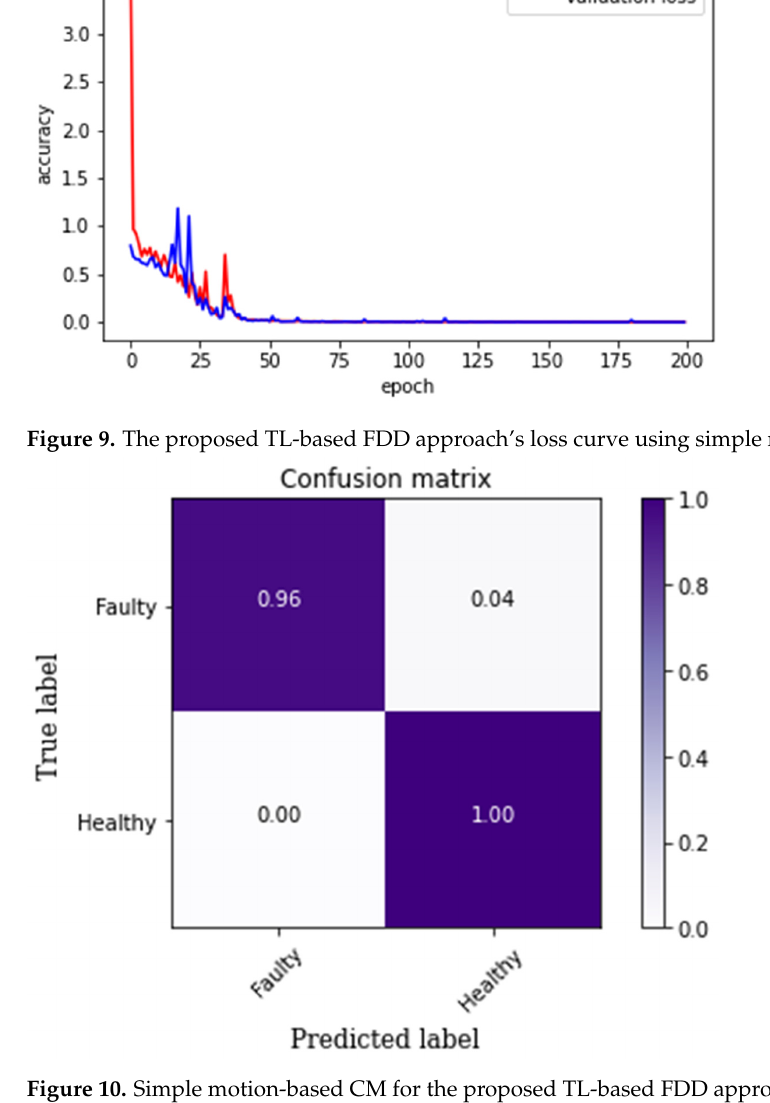
Figure 10. Simple motion-based CM for the proposed TL-based FDD approach.